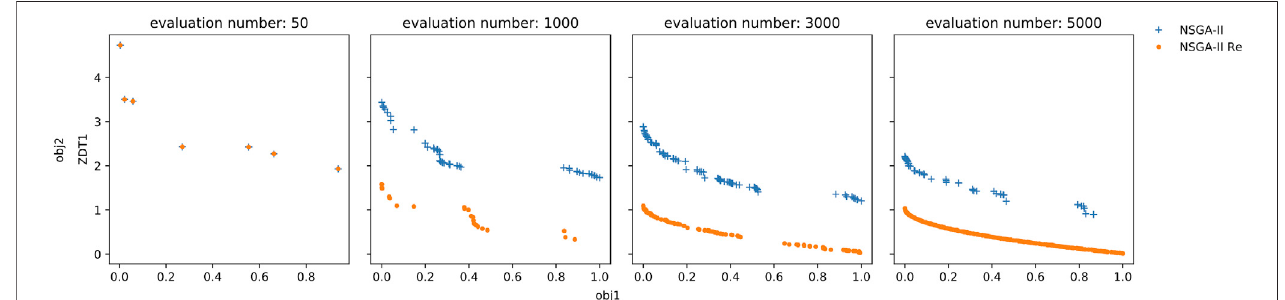
FIGURE 3 | Performance comparison between the original NSGA-II in C (orange dot) and a popular NSGA-II implementation in Matlab (blue cross). Each plot shows the Pareto fronts of the two algorithms at a certain evaluation number (number of evaluated individuals in the optimization process). The initial population is identical forthe twoalgorithms, asindicated in theleftmost plot. The twoobjectivesaretobe minimized soa lowerPareto front ispreferable. It ’ sobviousthatthe original NSGA-II performs much better than the Matlab one along the whole optimization process.